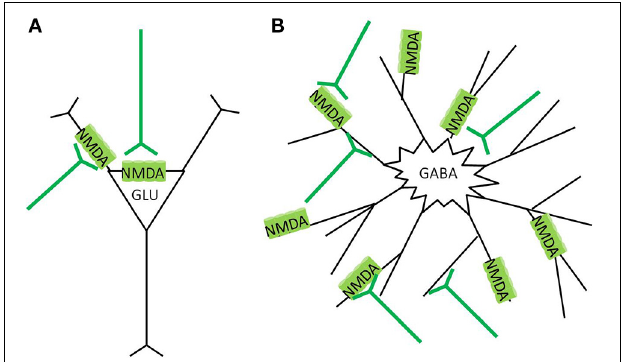
FIGURE 4 | NMDA receptor localization in the cortex. (A) Glutamatergic pyramidal neurons express NMDAreceptors preferentially in the post synaptic density (PSD) region, around the soma, and apical dendrites. Glutamate stimulation causes more focused calcium ion influx, and the cell has lower vulnerability to neurotoxicity (B) GABAergic interneurons express NMDA receptors more diffusely over the neuron, often at extrasynaptic locations. Glutamate stimulation causes widespread calcium ion influx, and the cell has greater vulnerability to